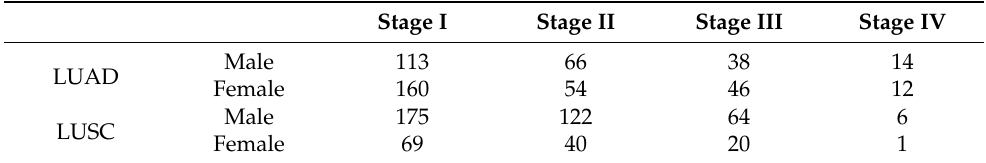
Table 2. Baseline data of the LUAD (lung adenocarcinoma) and LUSC (squamous cell carcinoma) samples in the TCGA (The Cancer Genome Atlas) database. The numbers in this table are the numbers of samples in each group of samples.